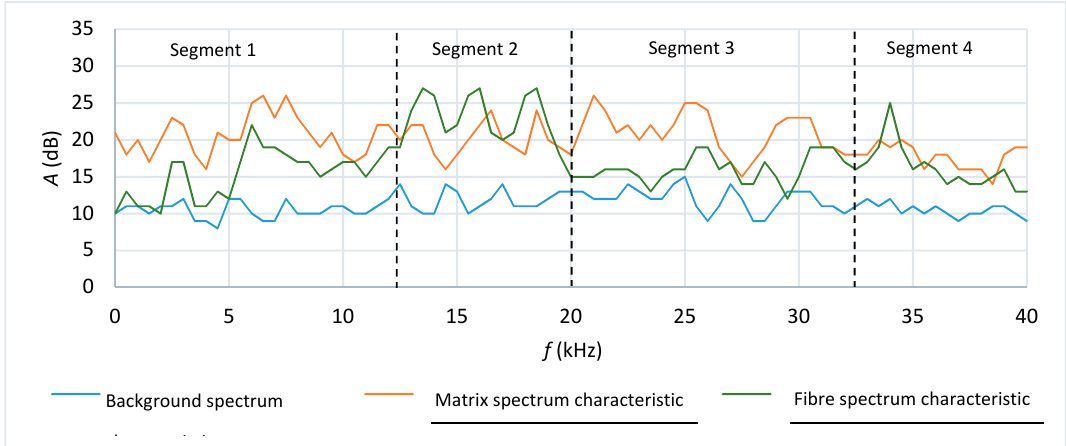
Figure 7. Background, fibre and cement matrix acoustic spectrum characteristics as function of frequency [12].